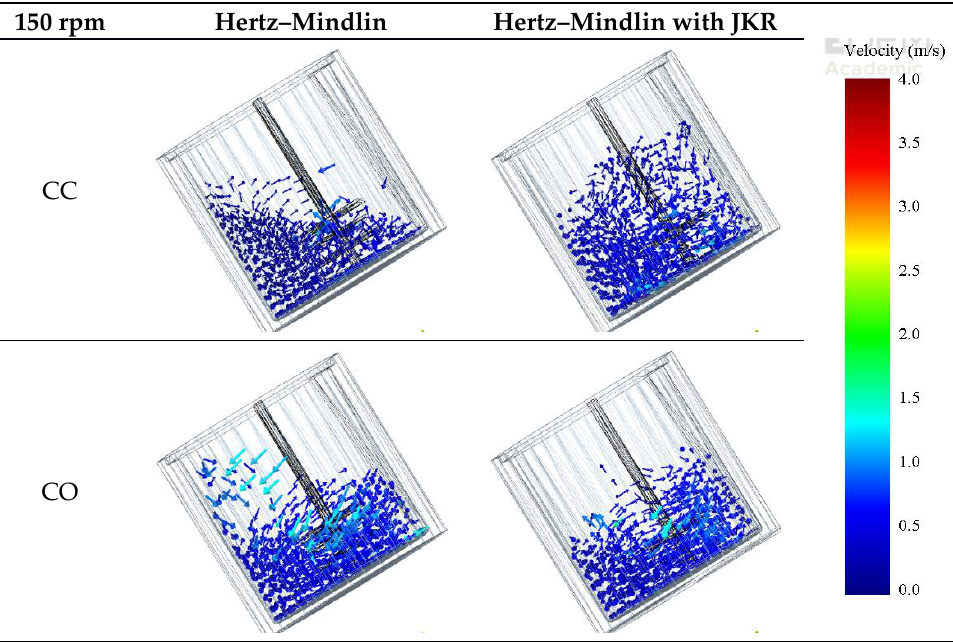
Figure 5. Comparison of simulated velocities of particles for the different contact models and modes of operation for an impeller frequency of 150 rpm.